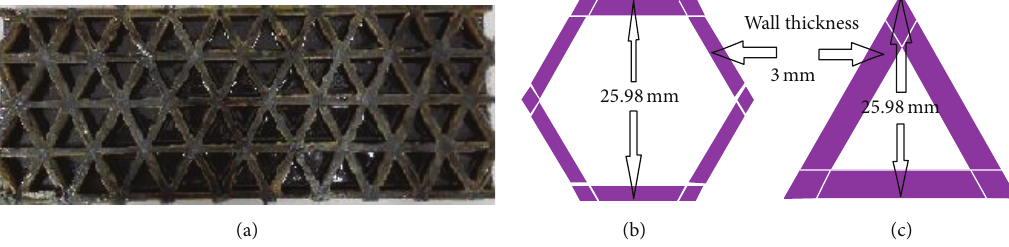
Figure 2: (a) Triangular lattice core. (b) One cell of honeycomb size. (c) One cell of triangular core size.